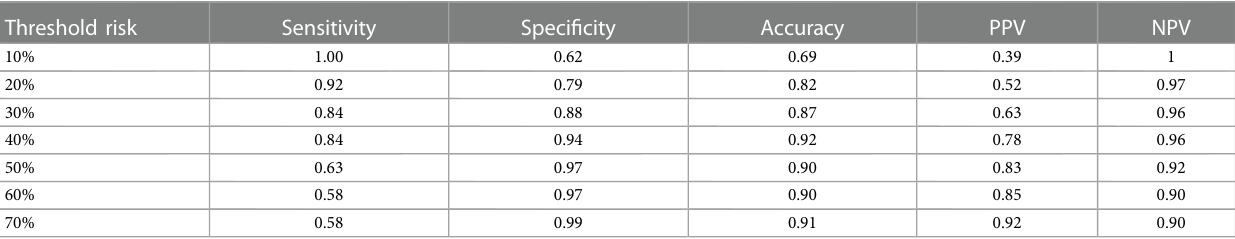
TABLE 3 The discrimination of the proposed model at different risk threshold settings. Threshold